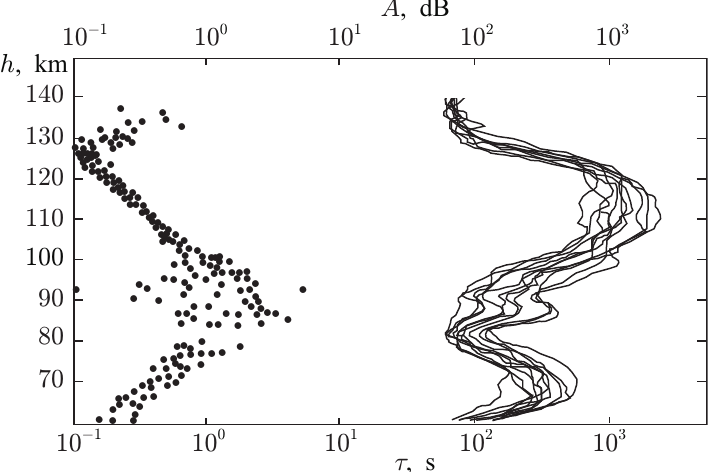
Fig. 2. Examples of the altitude dependences of the amplitude A (right panel) and the relaxation time (cid:28) (left panel) of the API scattered signal in the lower ionosphere measured during one hour on